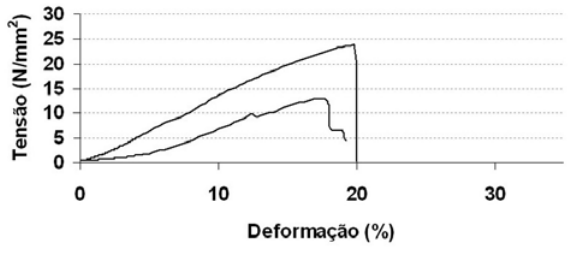
Fig. 1 – Curvas de tensão x deformação obtidas em função dos tratamentos